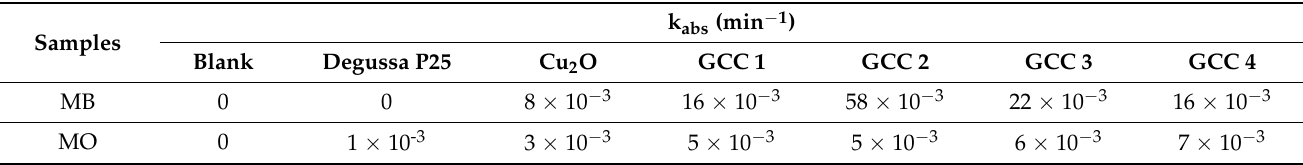
Table 3. Rate constant (k abs ) values for the degradation process.